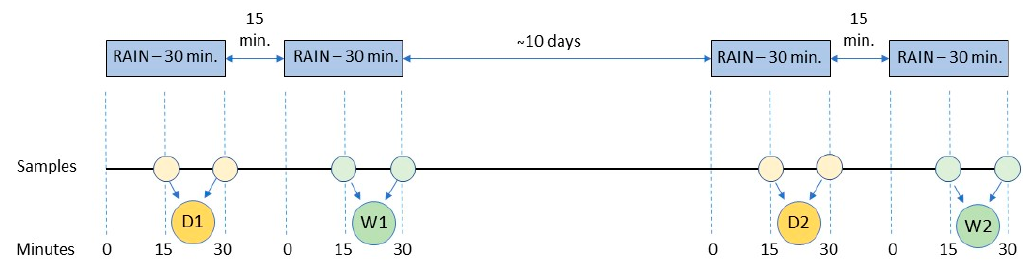
Figure 1. Experimental plots. Slope 34°, 30° and 22°. Dimensions 4.25 × 1 × 1.6 m. Rainfall simulator pulse nozzle system type WSQ 40. Location–Jirkov.